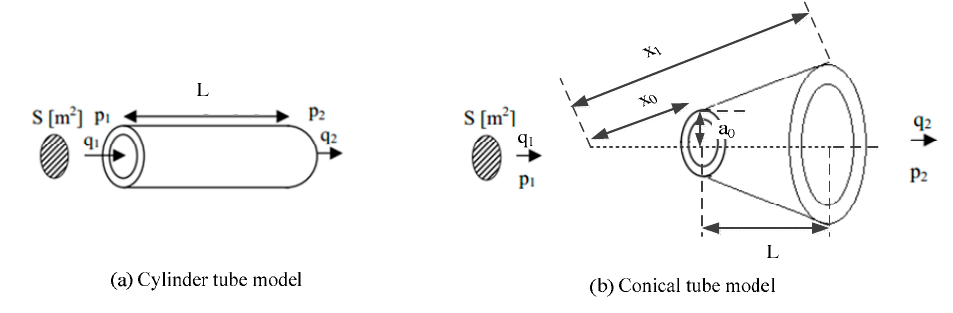
Figure 8. Tube Figure 8. Tube models.